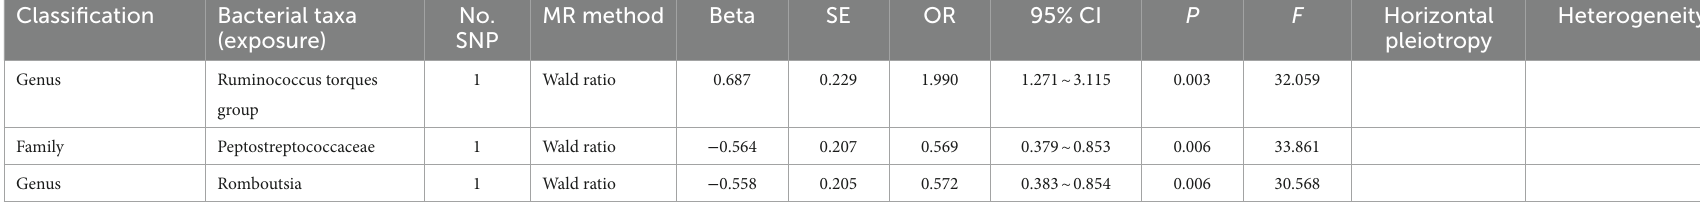
TABLE 3 Mendelian randomization analysis of gut microbiota on ADHD in discovery samples (genome-wide statistical significance Level, p < 5 × 10 − 8 ). Classification